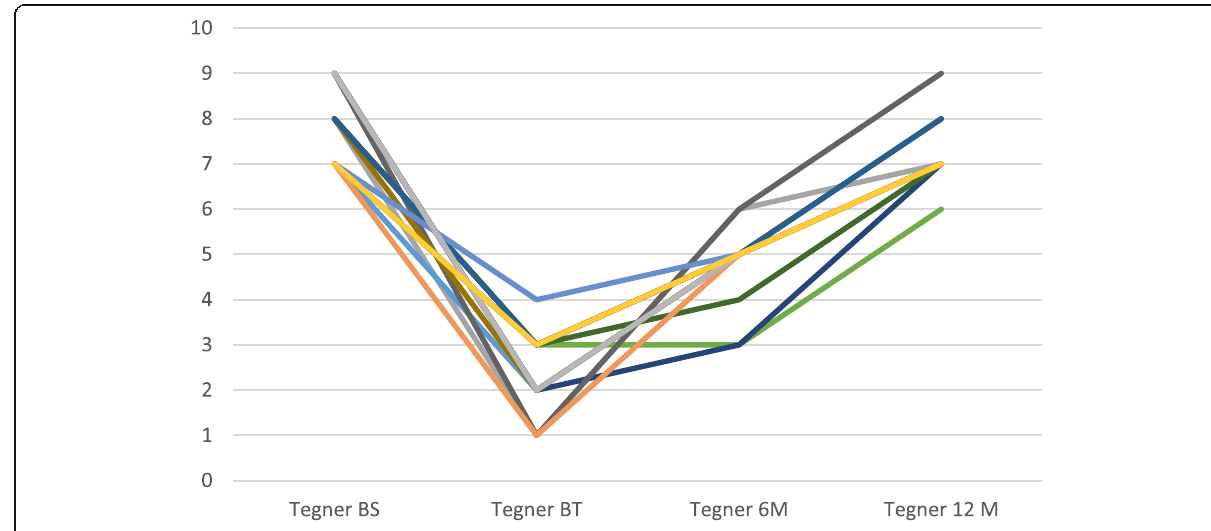
Fig. 5 Individual patient Tegner Score: BS: Before symptoms, BT: Before treatment, 6 M: 6 months post-treatment and 12 M: 12 months post-treatment